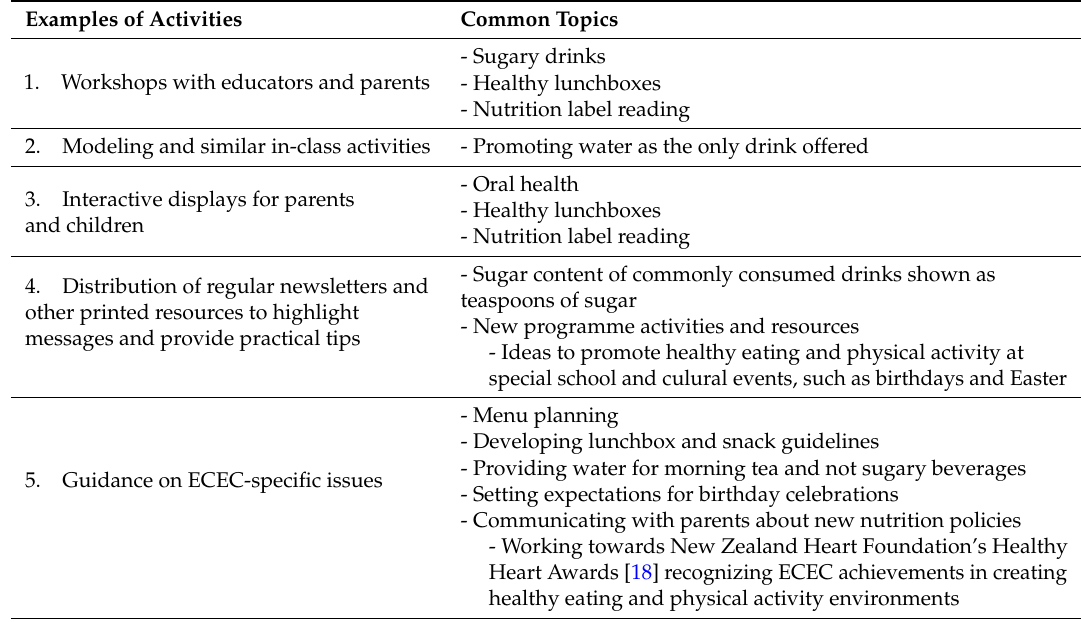
Table 1. Examples of activities and common topics.